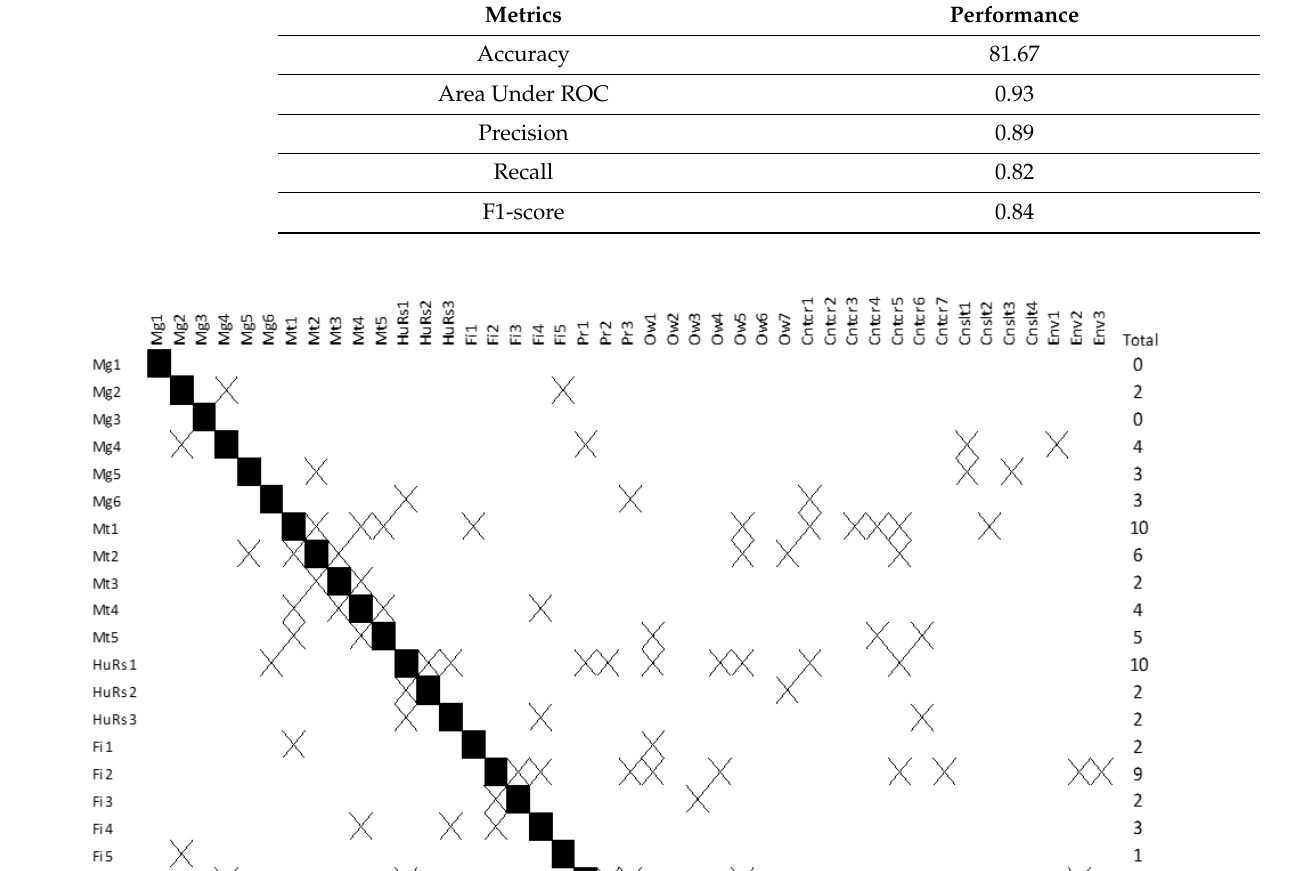
Table 7. K2GN-Un accuracy without the feature selection step.